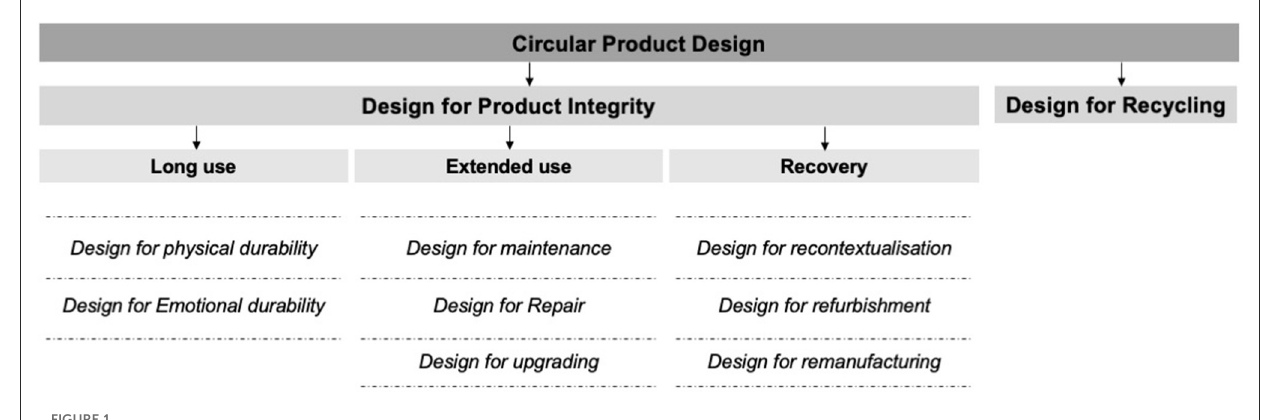
FIGURE1 Guiding principles that underpin product design for a CE (den Hollander,